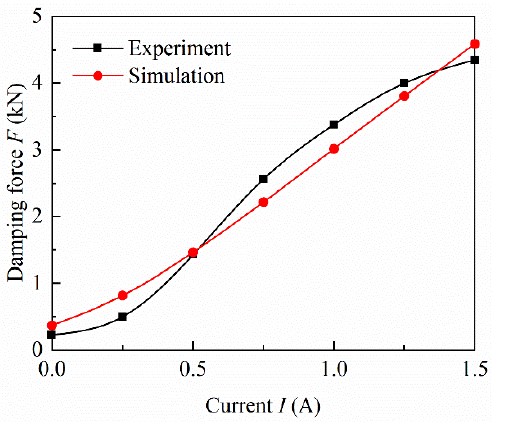
Figure 21. Comparison of damping force between simulation and experiment: ( a ) initial; ( b ) optimal.